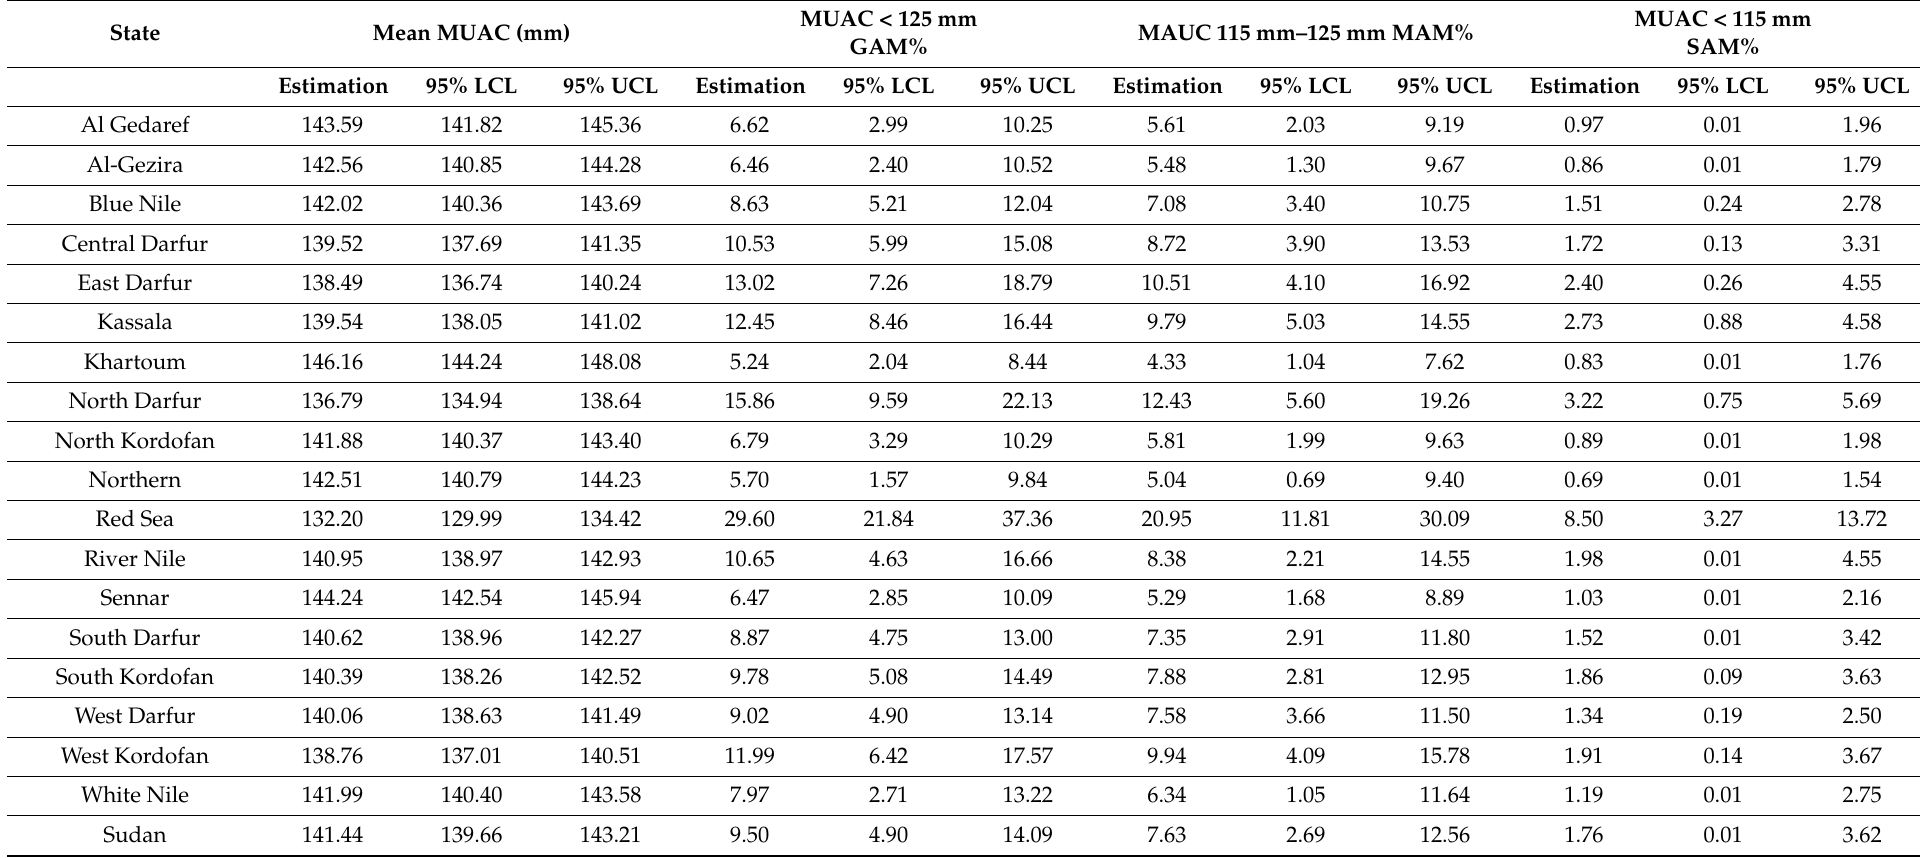
Table 5. Distribution of MUAC wasting prevalence and mean by